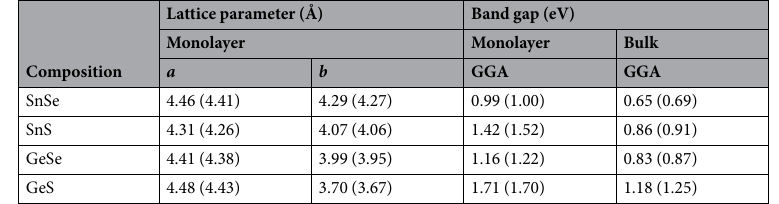
Table 1. Calculated lattice parmeters and band gaps of SnSe, SnS, GeSe, and GeS. The values in the parentheses are from the refs 18 and